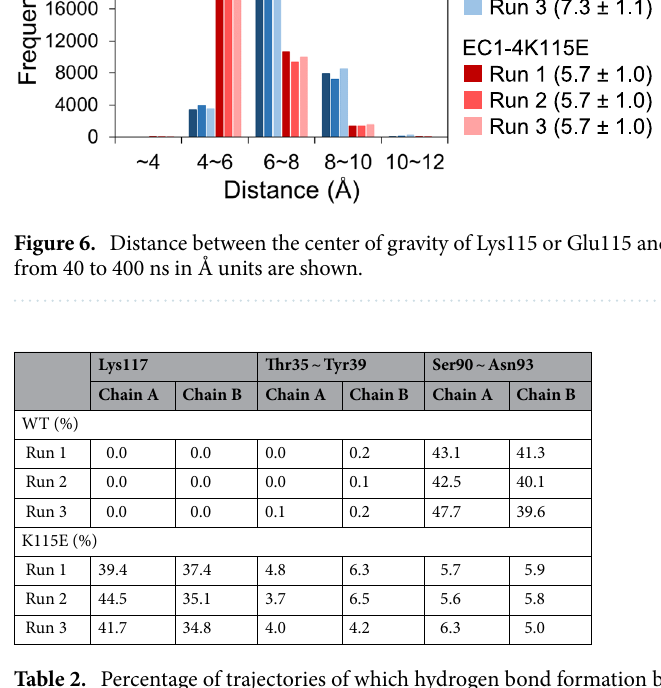
Table 2. Percentage of trajectories of which hydrogen bond formation between Lys115 or Glu115 and peripheral residues was confirmed. Trajectories from 40 to 400 ns were considered.